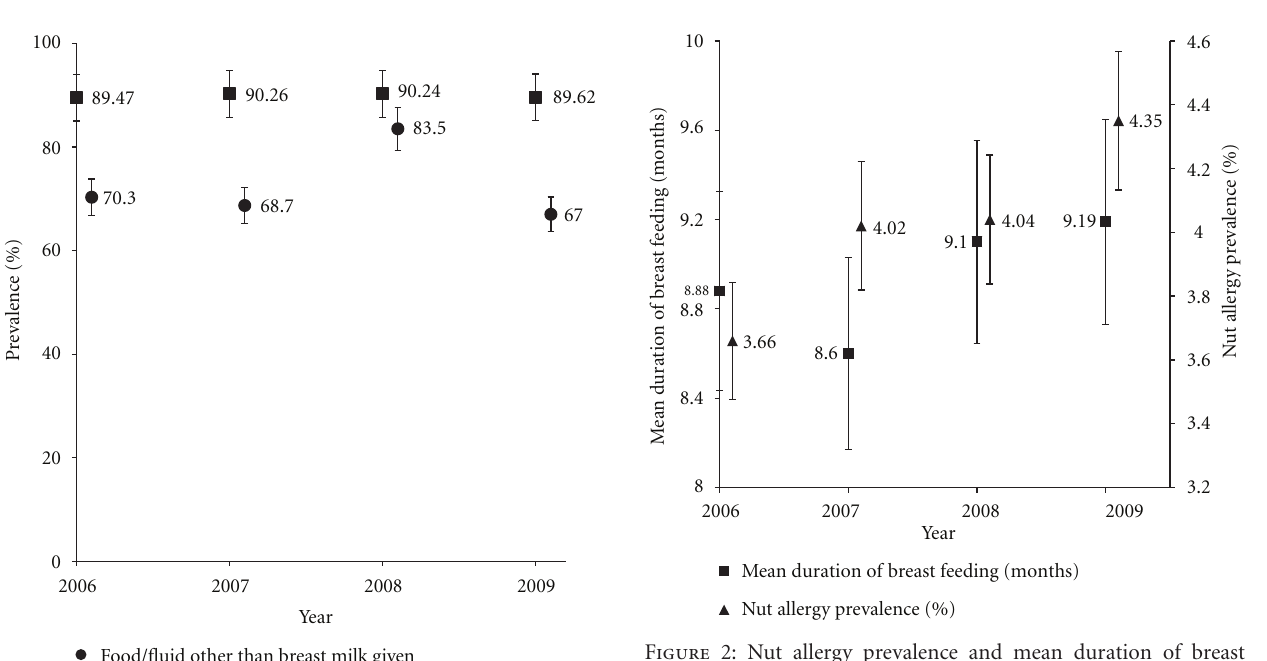
Figure 2: Nut allergy prevalence and mean duration of breast feeding between 2006 and